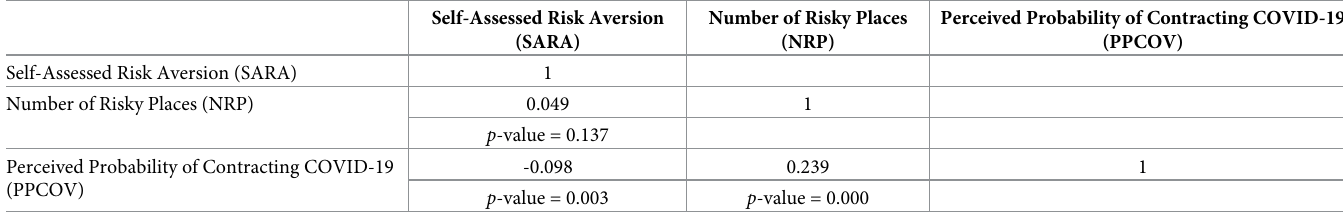
Table 2. Correlation matrix between different risk measures (n =